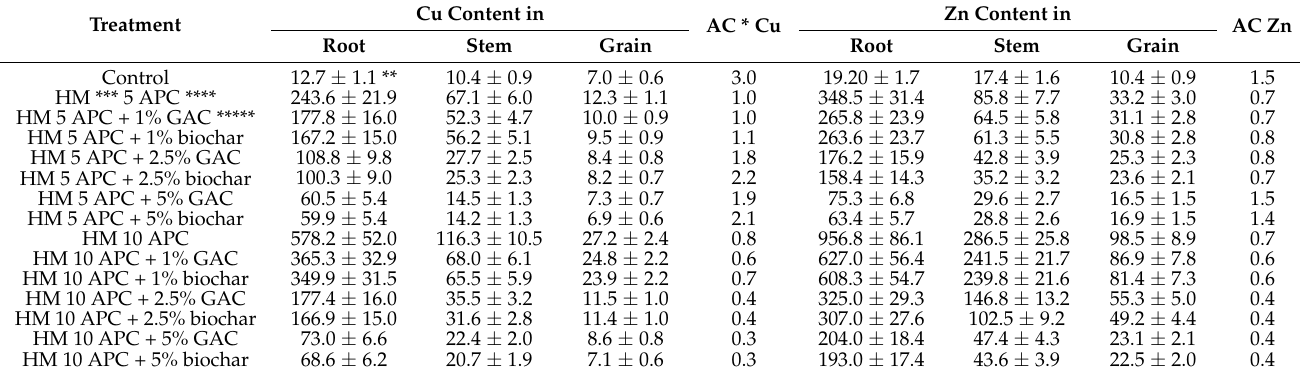
* AC—accumulation coefficient. ** Values represented are averages ± standard deviation; the number of replicates corresponded to three ( n = 3). *** HM—heavy metal. **** APC—approximate permissible concentrations for the total HM content. ***** GAC–granular activated